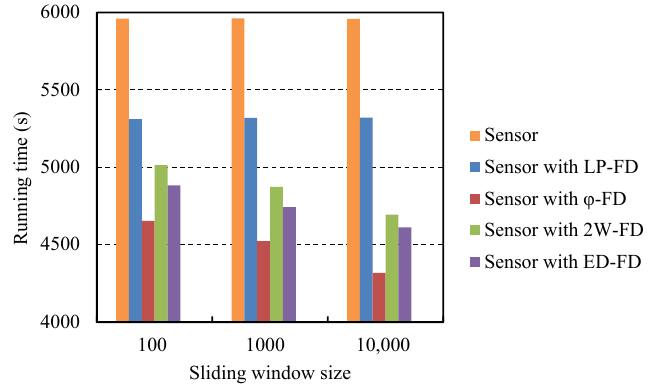
Figure 8. Comparison of battery consumption.